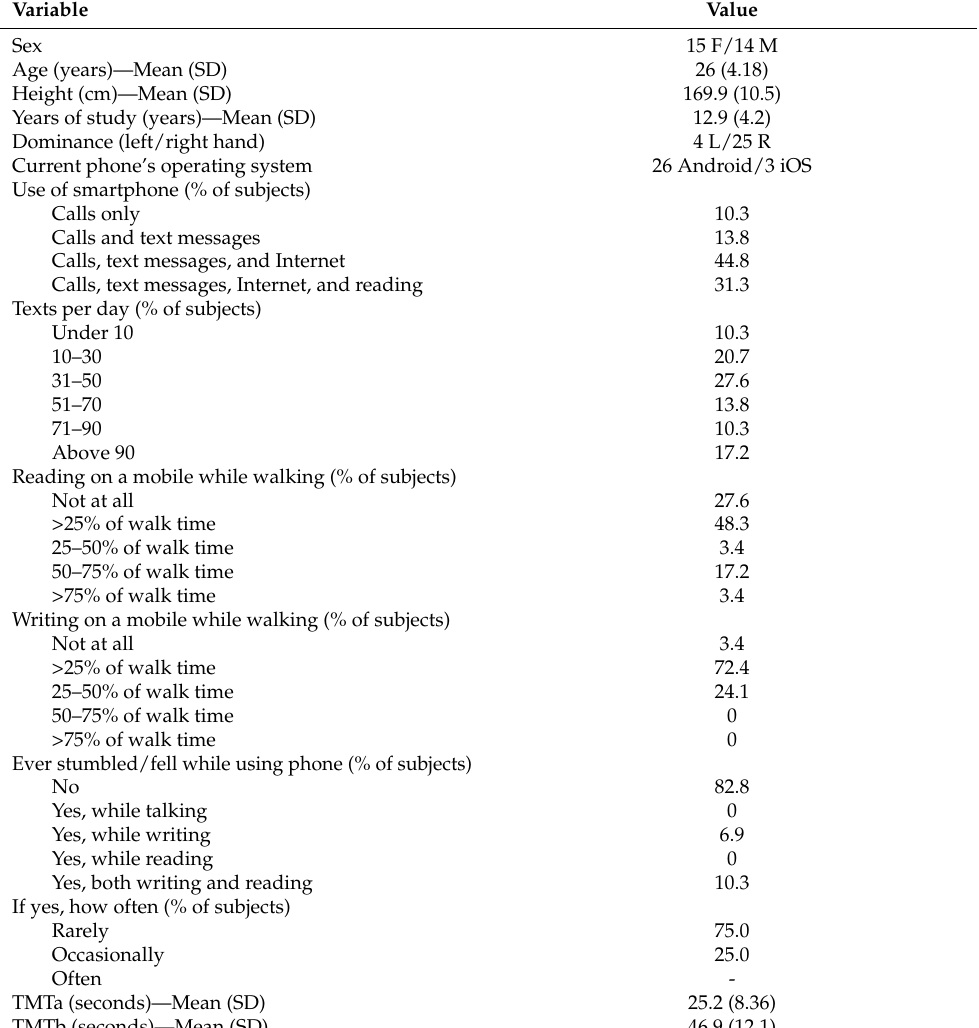
Table 1. Participants’